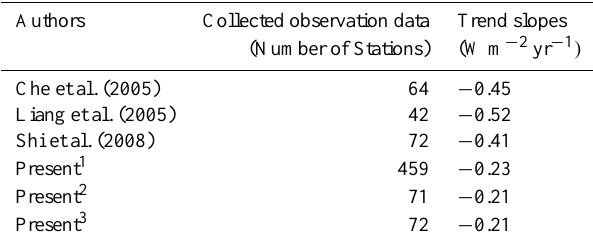
Table 4. Comparison of solar radiation trend slopes across China during 1961 ∼ 2000 between previous reports and present